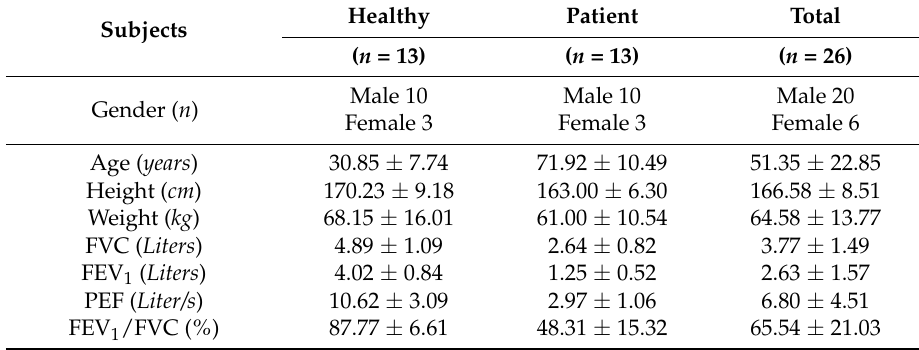
Table 2. Subjects’